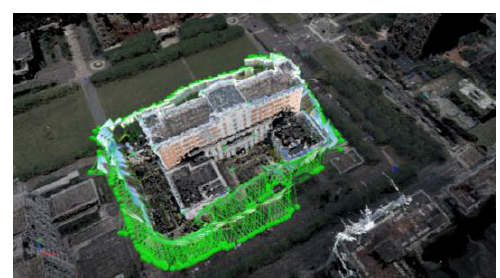
Figure 4. Vertical shooting photographs of the building by UAV.